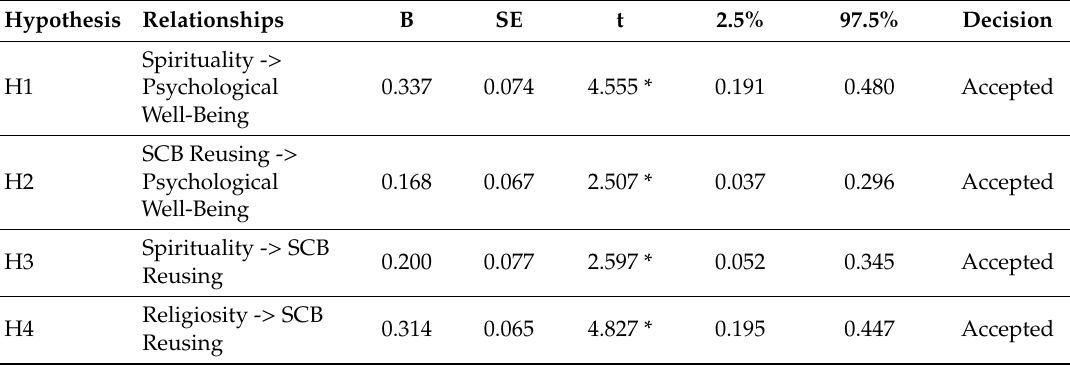
Table 4. Path coe ffi cients for direct